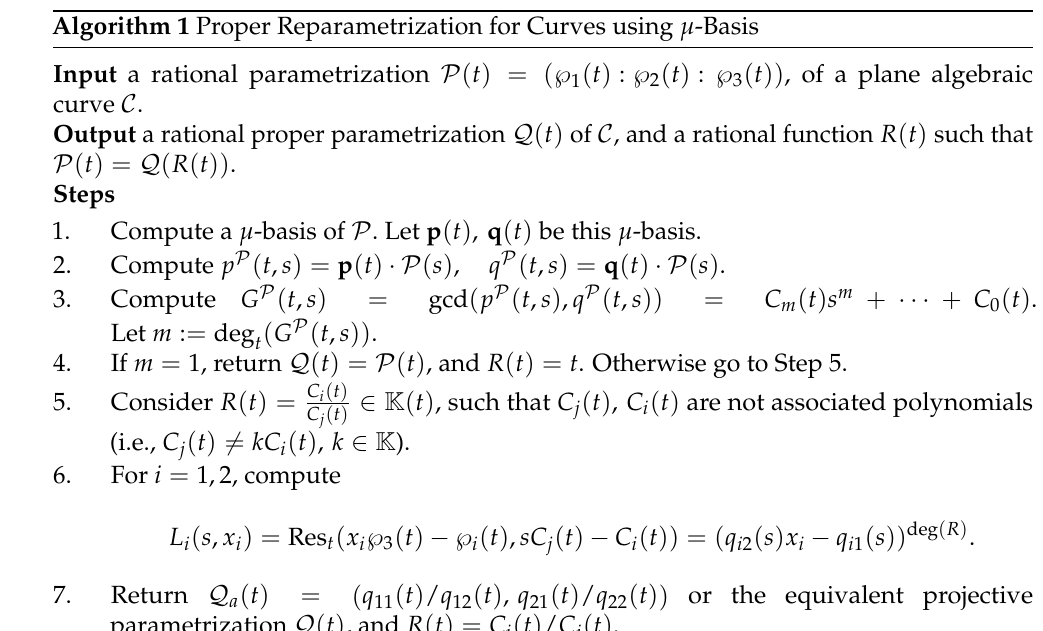
Algorithm 1 Proper Reparametrization for Curves using µ